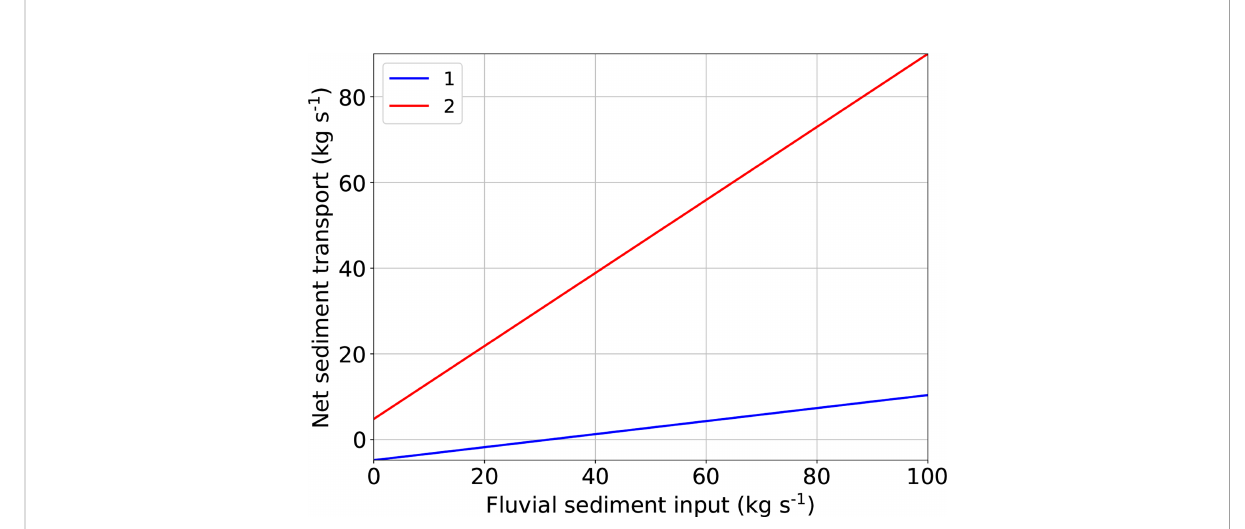
FIGURE 7 Sensitivity of net sediment transport in Channels 1 and 2 to fl uvial sediment